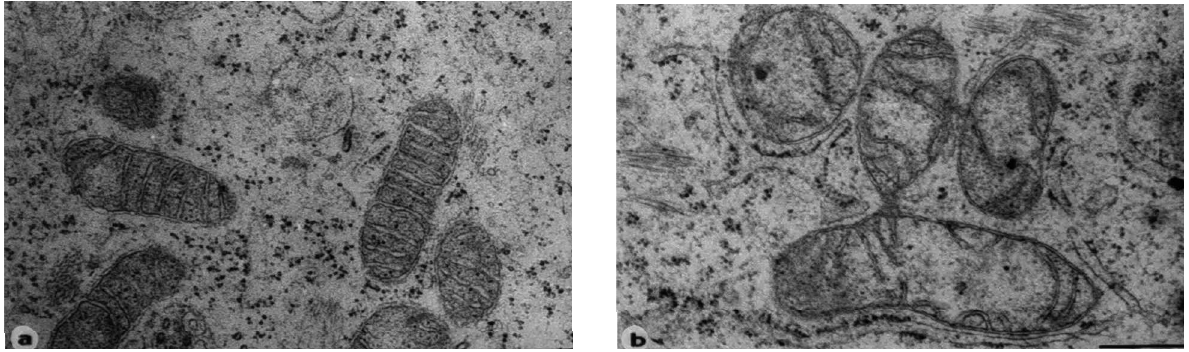
FIG. 2. Transmission electron micrographs of 16HBE14o– cells: (a) control, (b) exposed to 15 m M poly- L -arginine. Note changes in mitochondria. Bar = 0.5 m m.